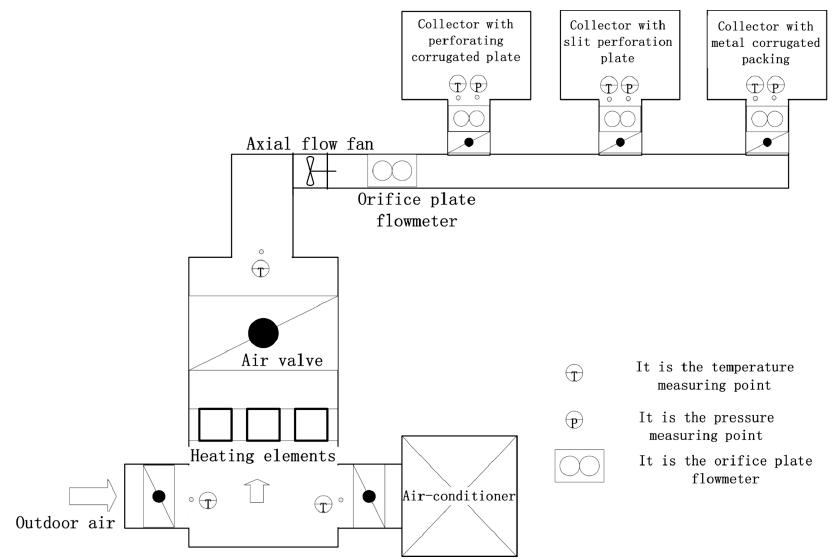
Figure 4. Schematic diagram of the experimental system. Table 1. Accuracy of the instruments used in the